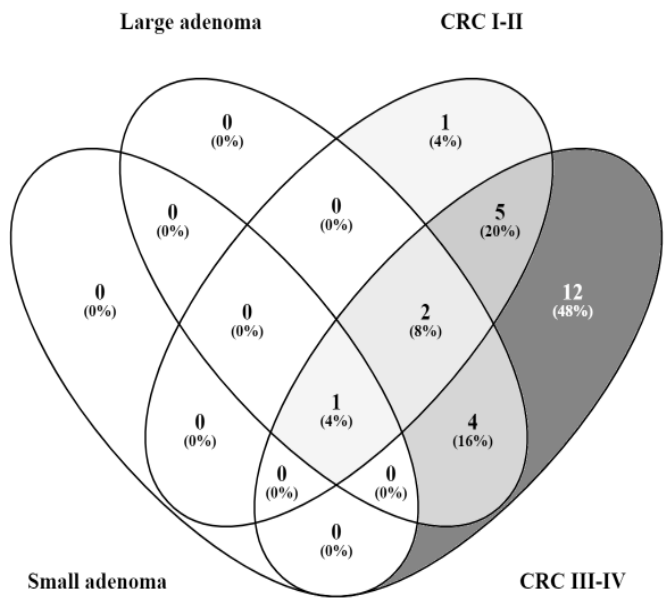
Figure 1. Venn diagram showing the number of shared and unique functions of targeted VFs detected in different stages of CRC.